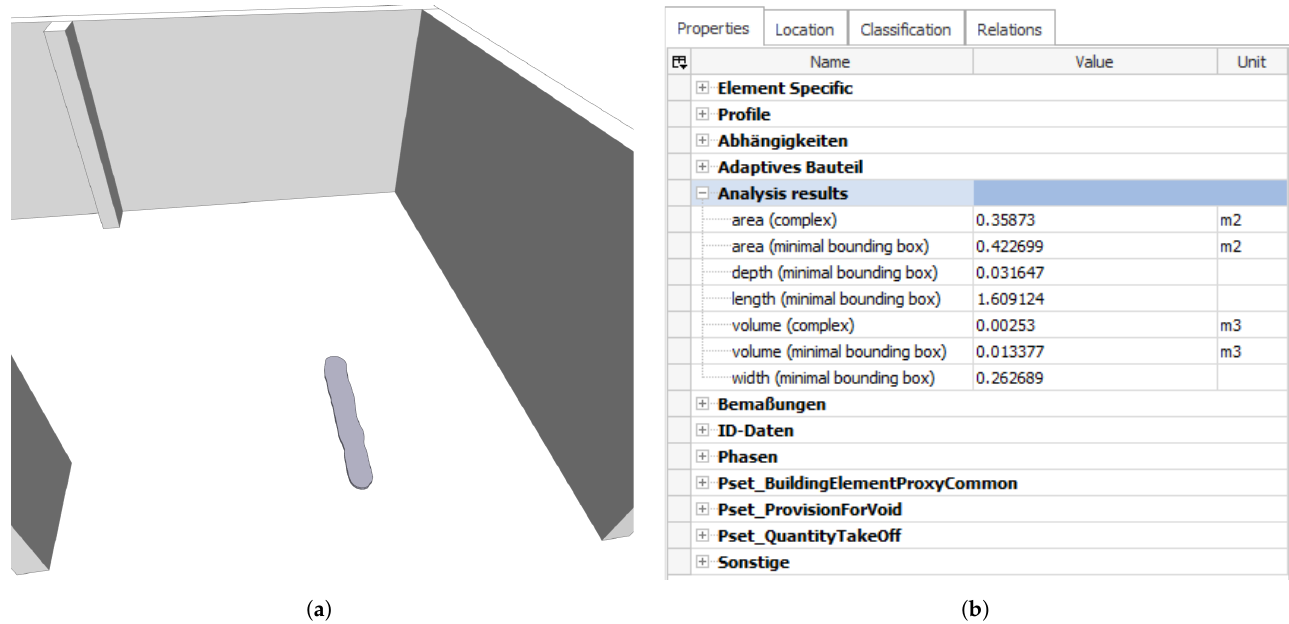
Figure 5. ( a ) Implementation of damage in BIM; ( b ) geometrical properties of the